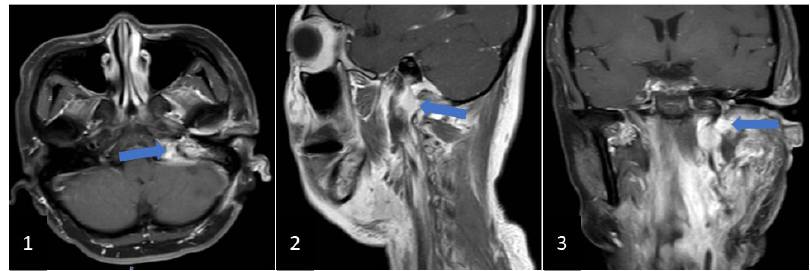
Figure 4. Images show the postoperative CE-MRI from the second surgery. ( 1 ), ( 2 ), and ( 3 ): presenting the reduced residual lesion behind the internal carotid artery. Blue arrow: residual lesion.